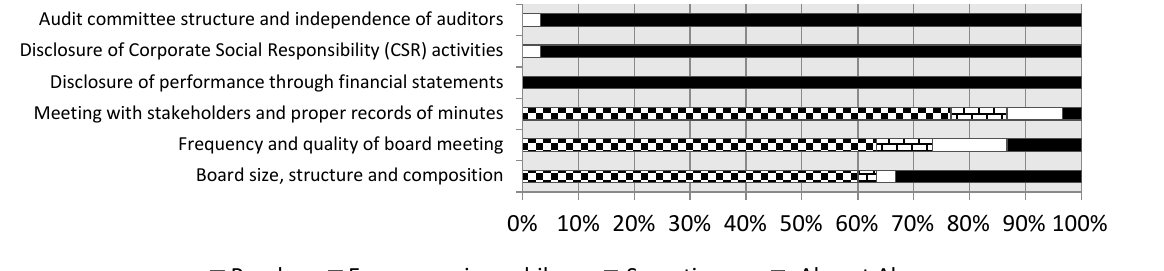
Figure 3. Governance issues considered in ESG risk assessment (respondents were allowed to pick multiple